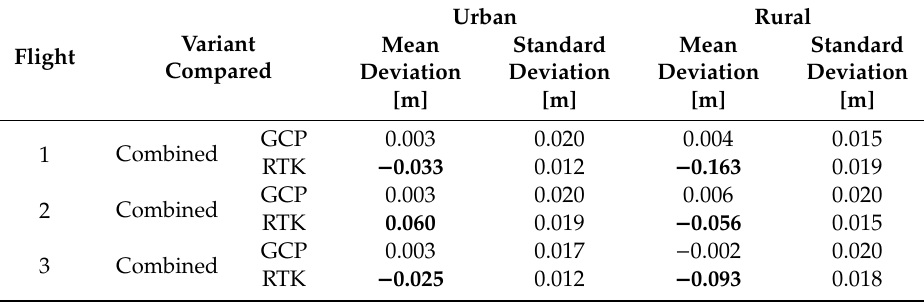
Table 9. Comparison of the GCP and RTK variants with the Combined variant.